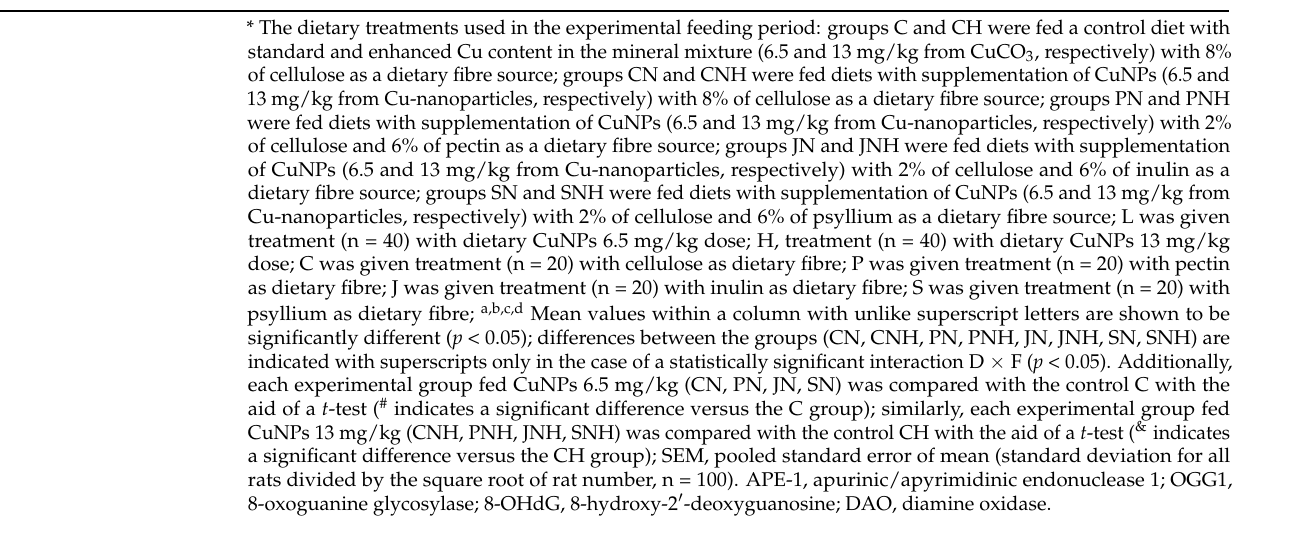
Table 7. Level of gene expression in the small intestine of rats fed experimental diets (n = 10 per group)